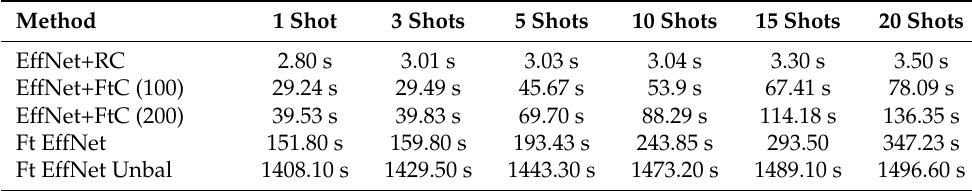
Table 7. Time spent for training at different number of